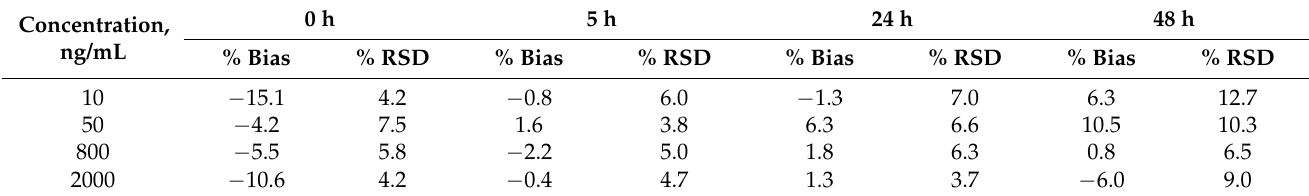
Table 3. Stability of ST-246 in plasma after 48 h storage at 4 ◦ C.